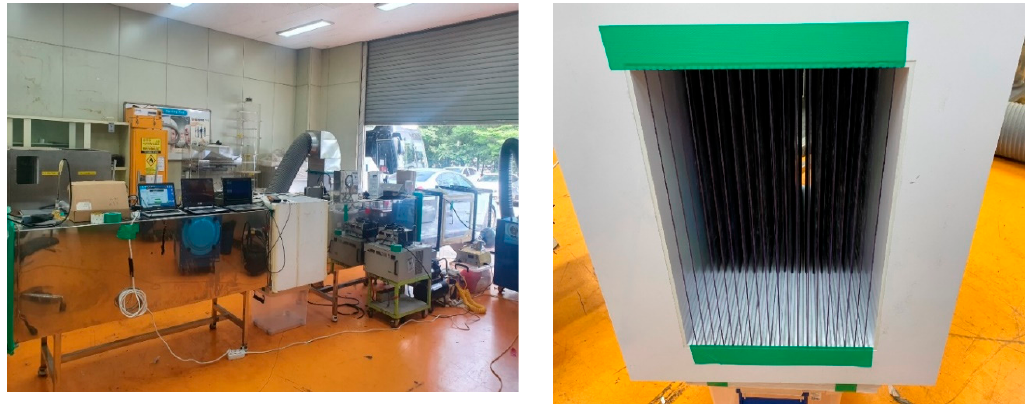
Figure 2. The reactor and test specimen used for the ACF efficiency measurements.